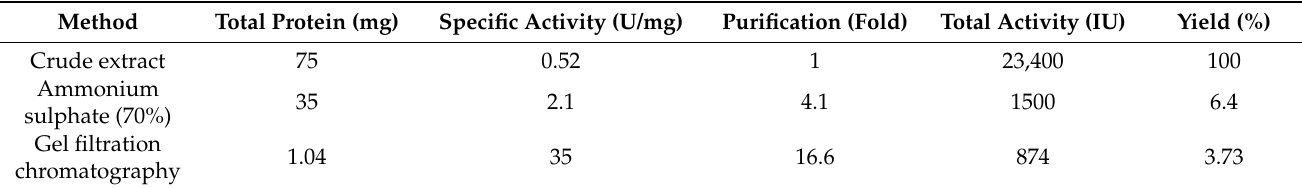
Table 4. Sequential stages of purification of L-glutaminase produced by A. xylosoxidans RSHG1.